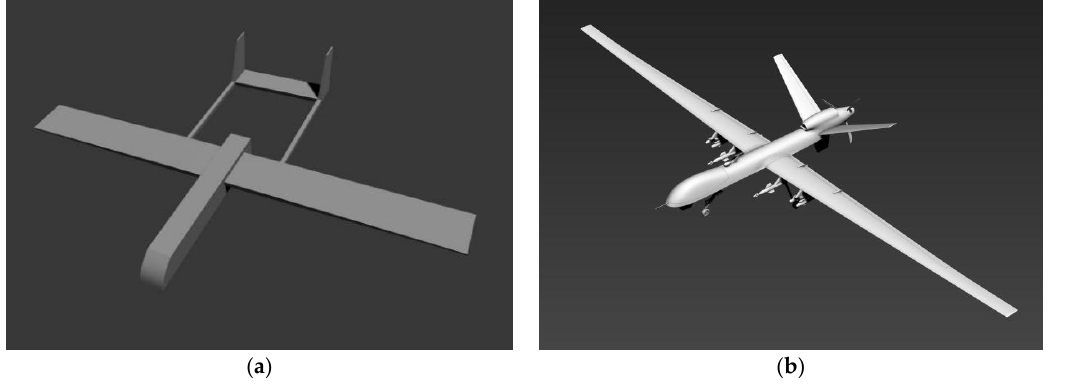
Figure 10. Two aircraft models: ( a ) Model 1; ( b ) Model 2.